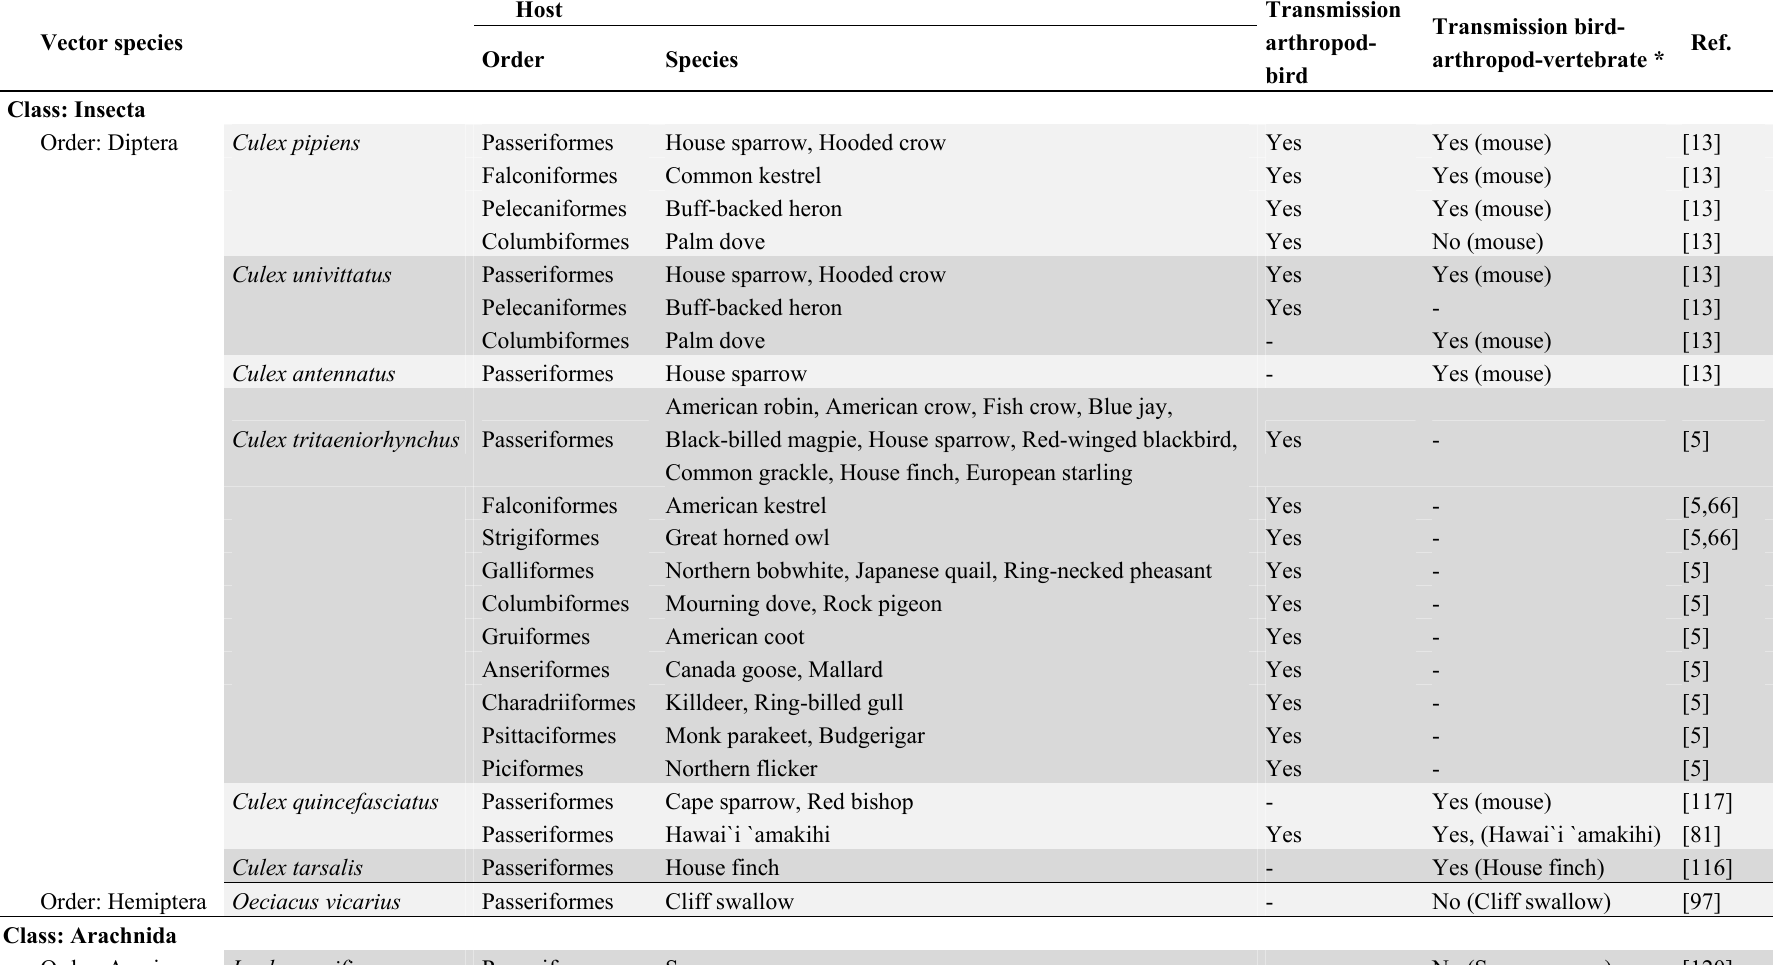
Table 2. Arthropod-borne transmission in experimental WNV infections in wild